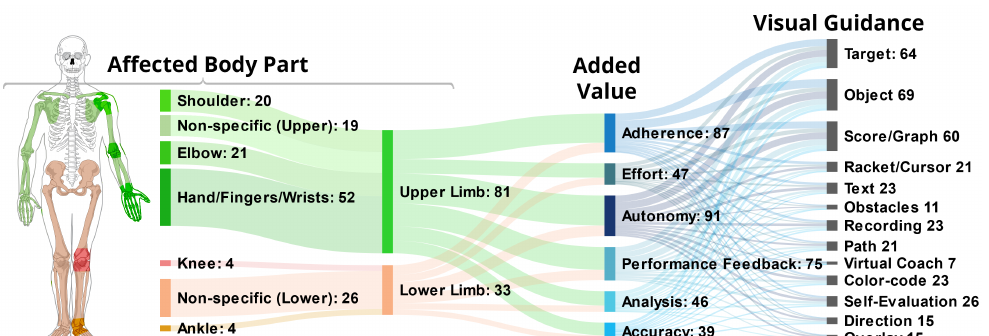
Figure 6. Connections between selected elements of the reviewed literature.